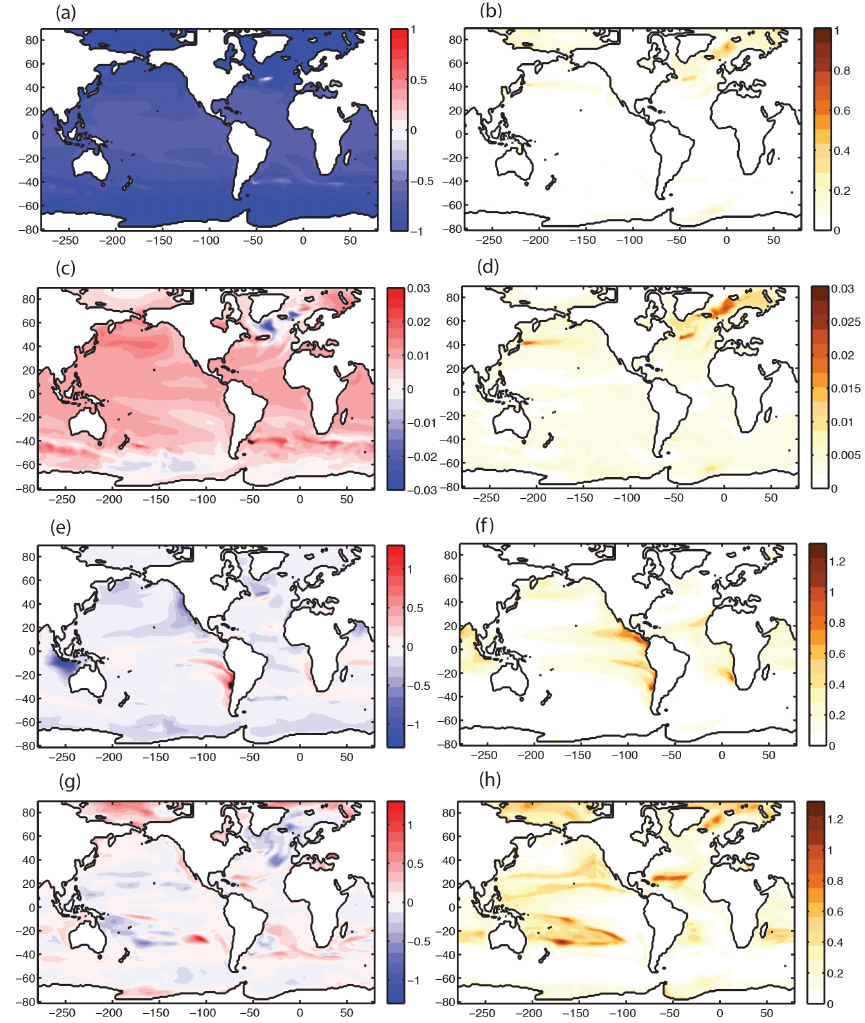
Figure A2. Linear trends (left) and standard deviations of the linear trends (right) for (a, b) (cid:127) arag (c, d) SST (e, f) O 2 inventories from 100–600m, and (g, h) net primary production averaged over 2075–2084. All fields are calculated using 30-year trend windows, and the trends are shown in units of